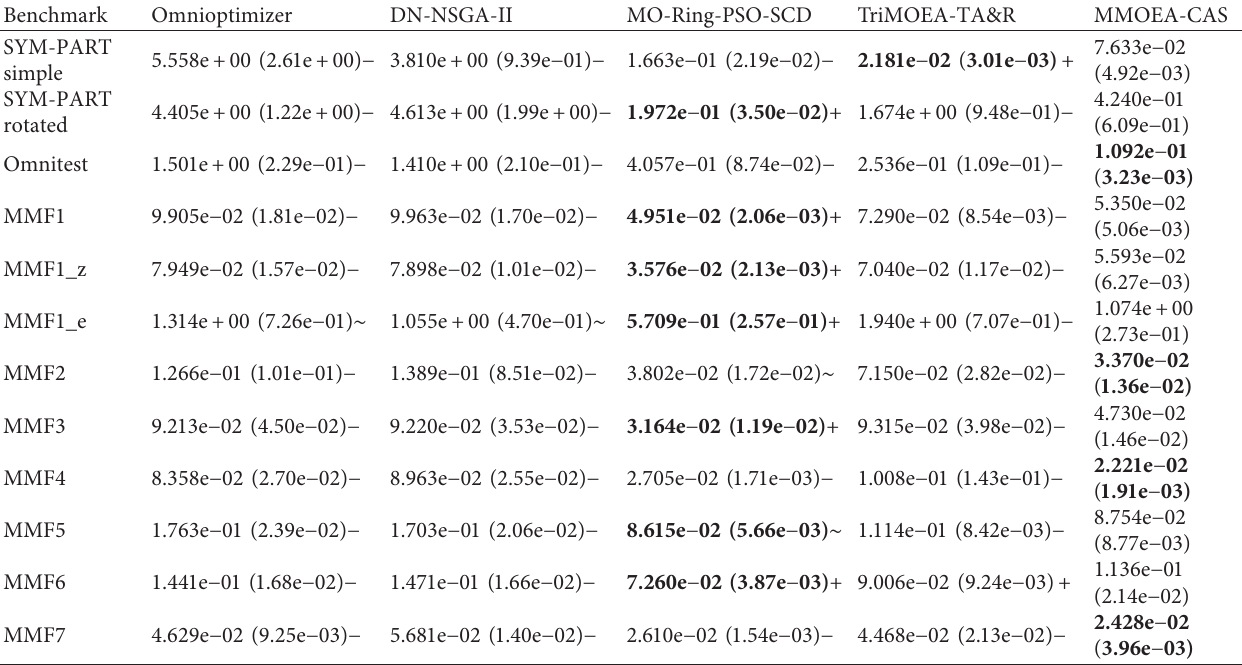
Table 3: Results obtained by four other MMOEAs and MMOEA-CAS on